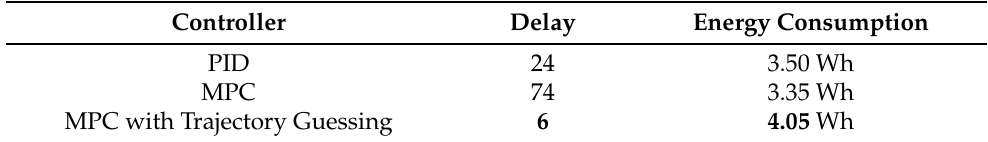
Table 1. Comparison of the attitude